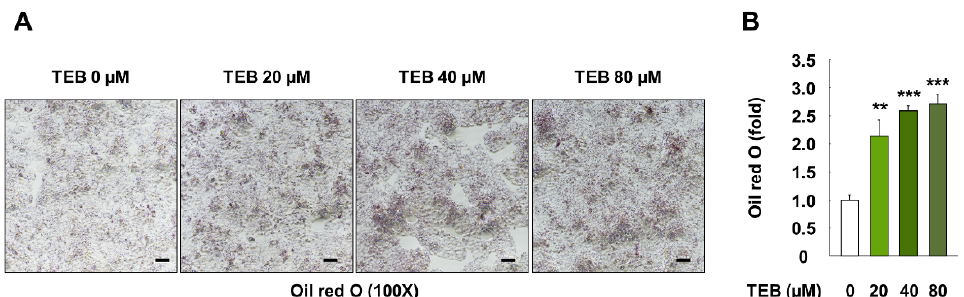
Figure 2. Lipid accumulation in HepG2 cells treated with TEB. ( A ) Microscopy images (100 × , black bar = 100 µ m) and ( B ) quantification of areas stained with Oil Red O in HepG2 cells. The cells were exposed to 20, 40, and 80 µ M TEB for 24 h ( n = 3 wells/group). The data are represented as mean ± SEM. ** ( p < 0.01) and *** ( p < 0.001) show a significant difference, compared to the control (DMSO).